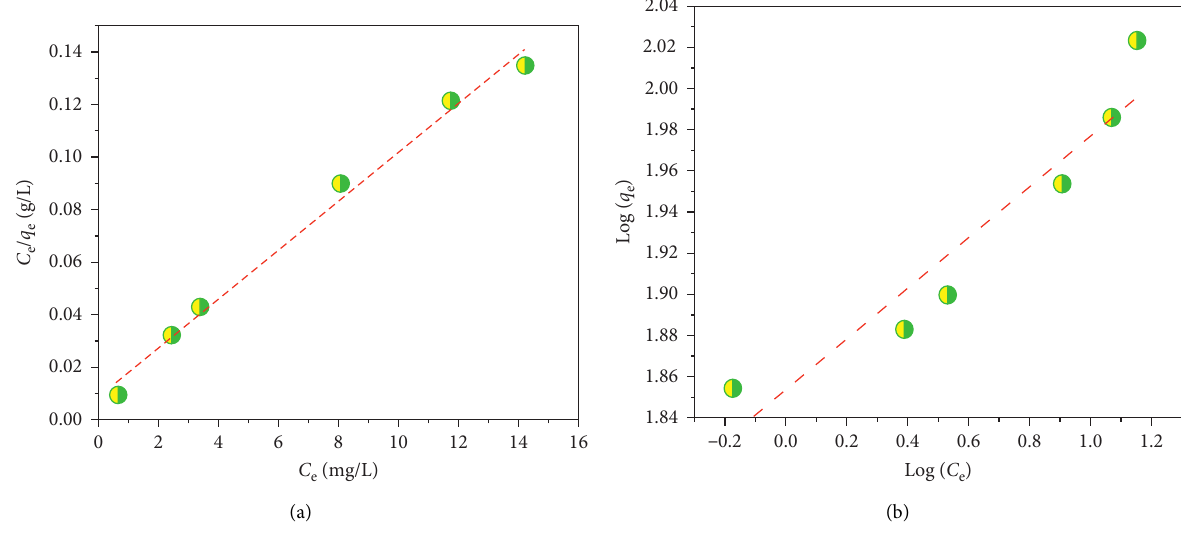
Figure 11: Langmuir isotherm plot (a); Freundlich isotherm plot (b).